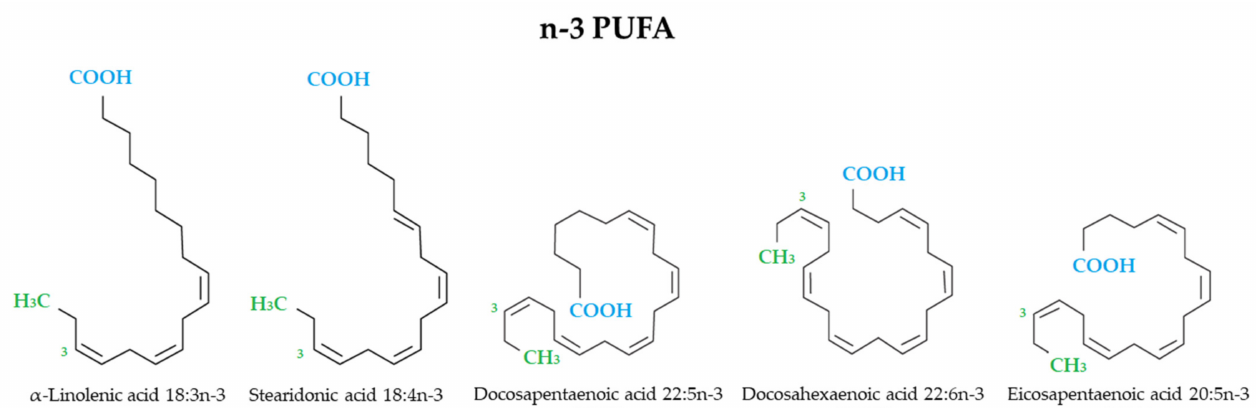
Figure 1. Structural formulae of n-3